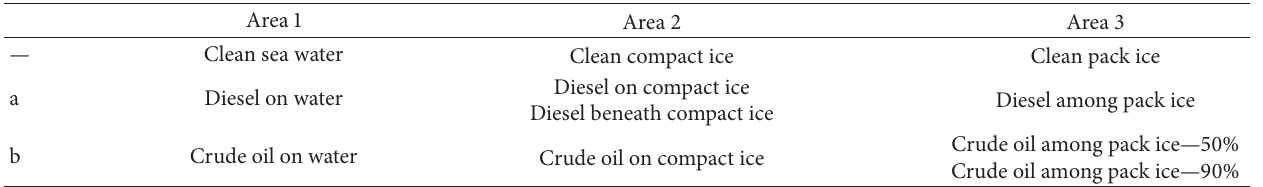
Table 1: Scene of the reflectance